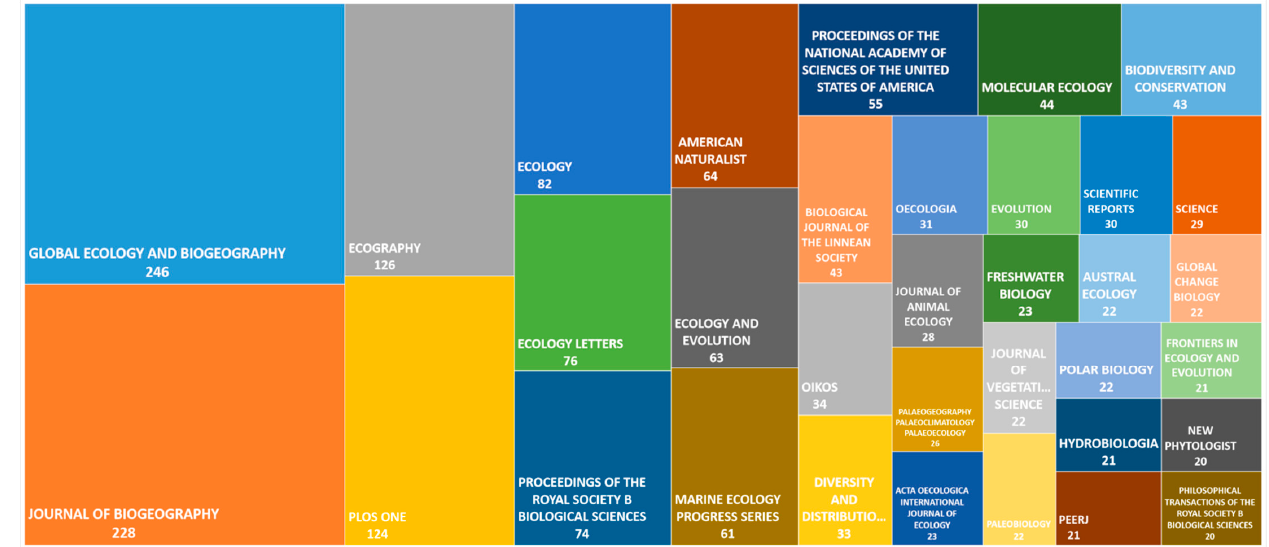
Figure 2. Number of documents per journal relating to the LDG research using the keywords “latitudinal diversity gradient” from Web of Science (Data accessed on 22 February 2022); only journals with more than 20 published papers are shown. The size of a block is proportional to the number of relevant papers in the given journal.